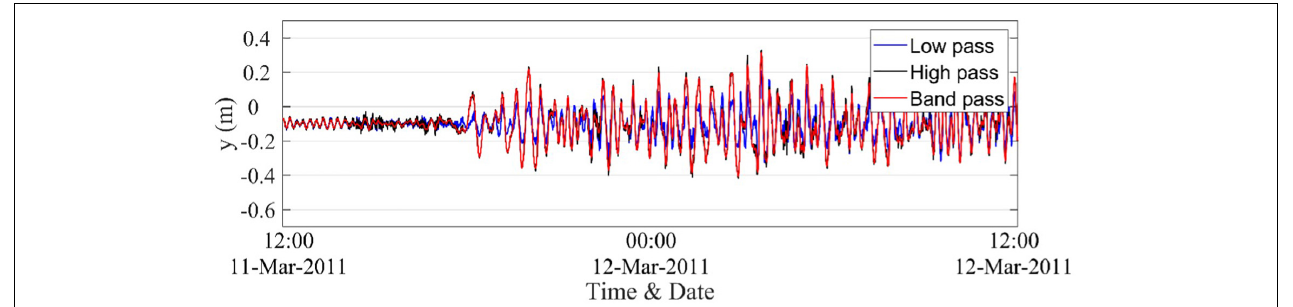
FIGURE 9 | Comparison of three filtering methods applied to a tsunami record.